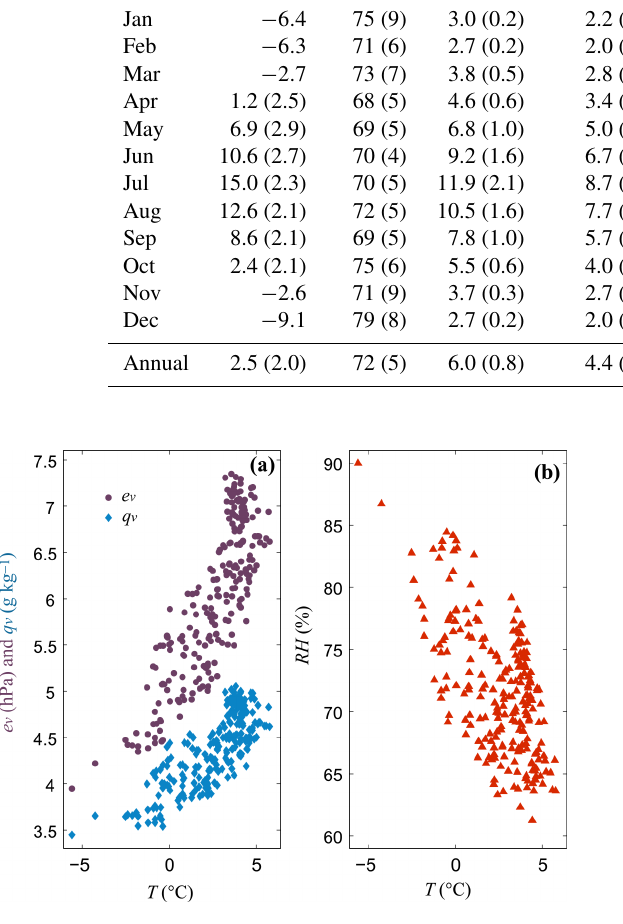
Figure 4. Mean annual humidity data as a function of mean annual temperature at each FCA site. (a) Vapour pressure (brown circles) and specific humidity (blue diamonds). (b) Relative humidity (red triangles).